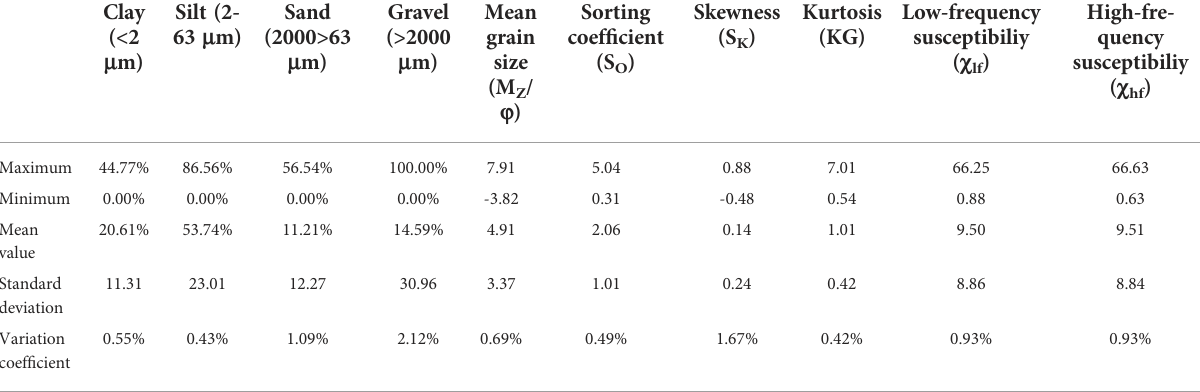
TABLE 5 The grain size composition and parameters characteristics and magnetic susceptibility results of the FC borehole in